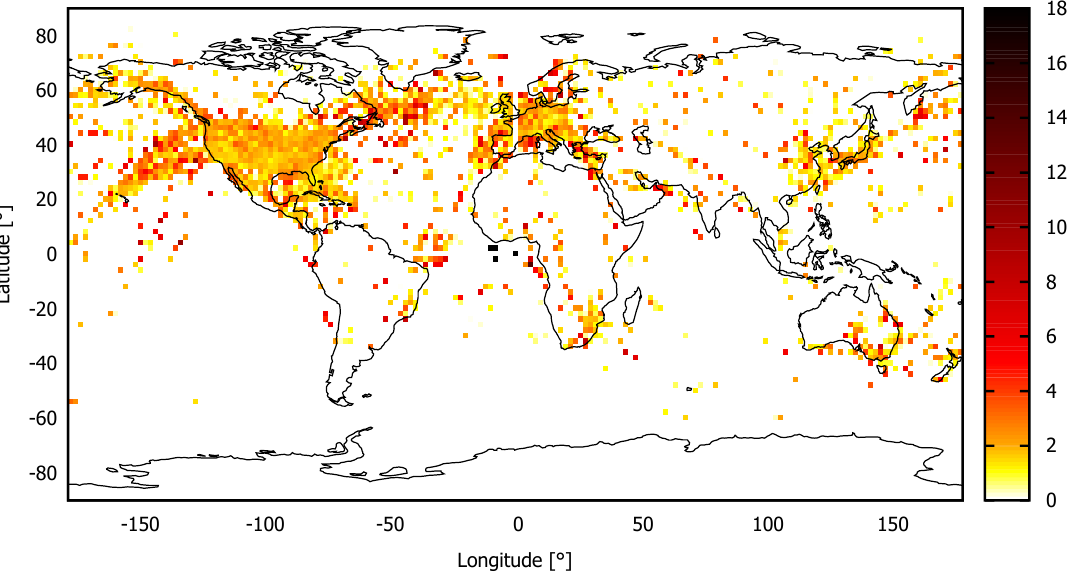
Figure 5. Mean differences in local wind speed between aircraft measured AMDAR data and the closest global GFS model output on 29 January 2020. On average, the GFS modeled mean wind speed deviates 3 ms − 1 from the AMDAR output at the same time. Additionally, the global distribution of AMDAR measurements can be